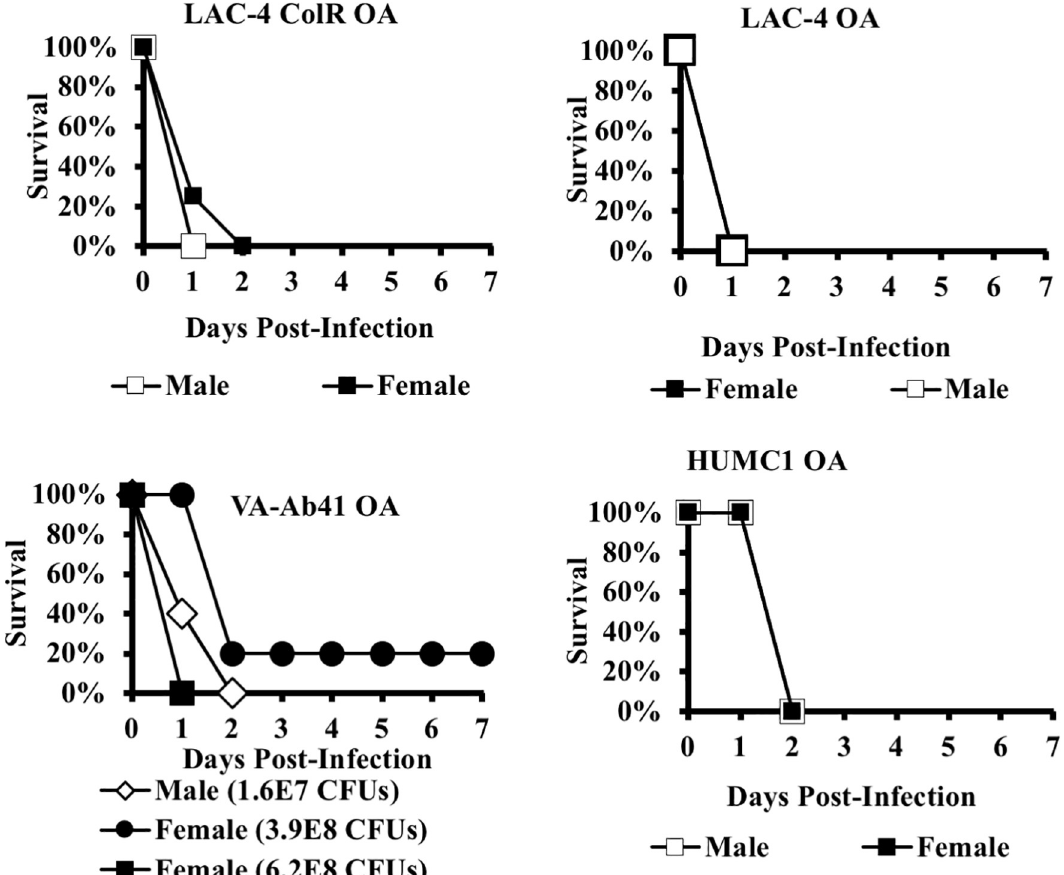
Fig 2. The effect of gender on mouse susceptibility, OA infection model. Mice were infected with the LD100 inoculum listed in Table 1 unless otherwise specified. Variation in host susceptibility by gender was not consistently observed across all strains or infection routes. In the OA infection model, a gender effect (males were more sensitive as compared to females) was only observed with mice infected with VA-AB41.